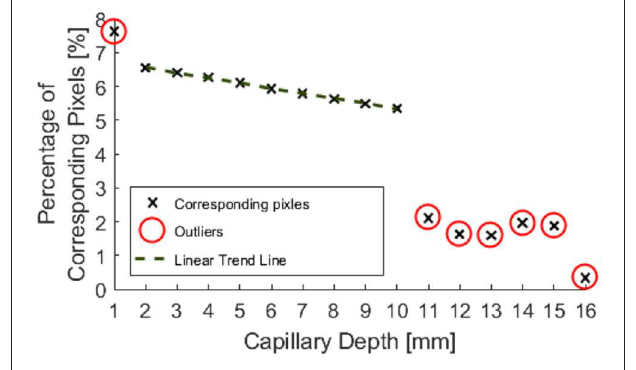
FIGURE 8 | Percentage of pixels for which a corresponding pixel could be found in the partnering stereo image, for controlled submersion depth.